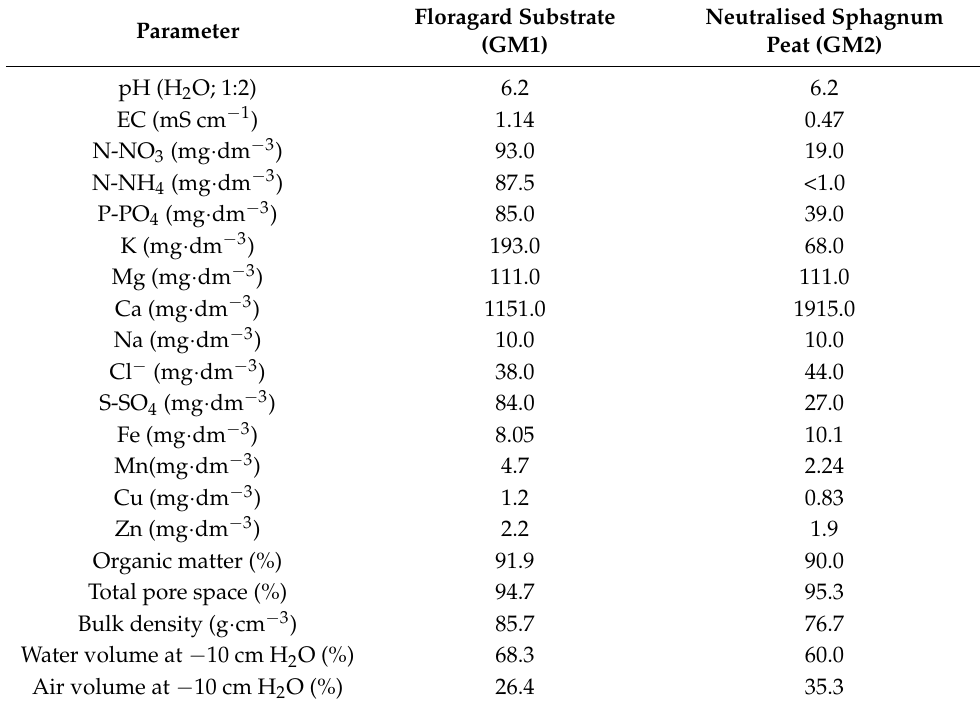
Table 1. Initial nutrient concentrations and selected physical and chemical properties of the substrates. Floragard Parameter